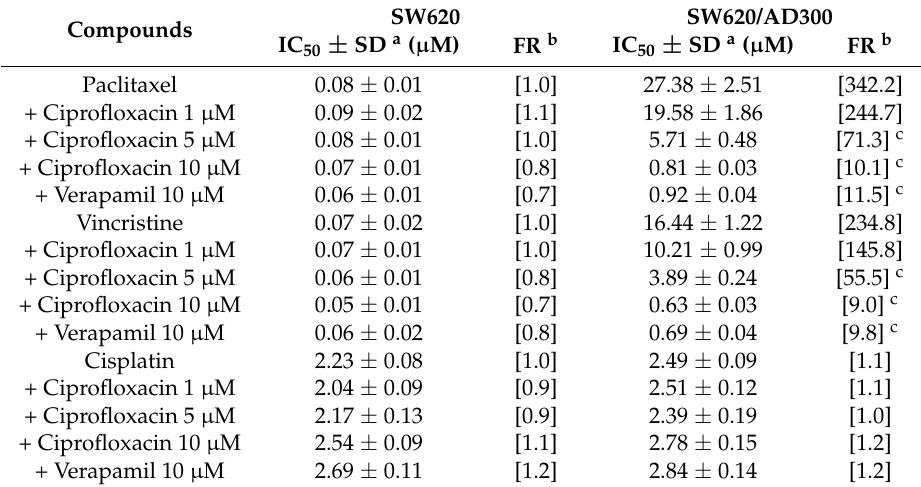
Table 1. The effect of ciprofloxacin on reversal of ABCB1-mediated MDR.